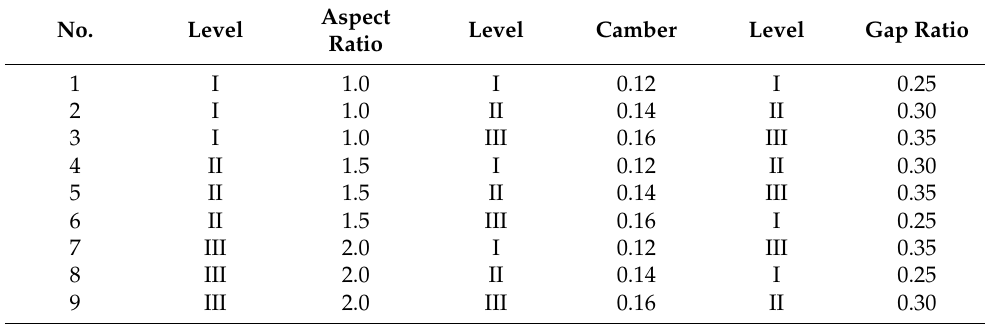
Table 2. Factor combinations of the otter board model.